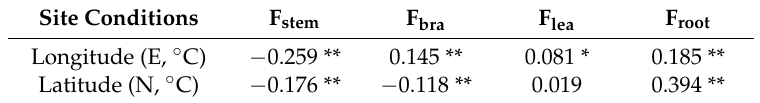
Table 3. Pearson correlations between four biomass allocation fractions (BAFs) and site conditions. Site